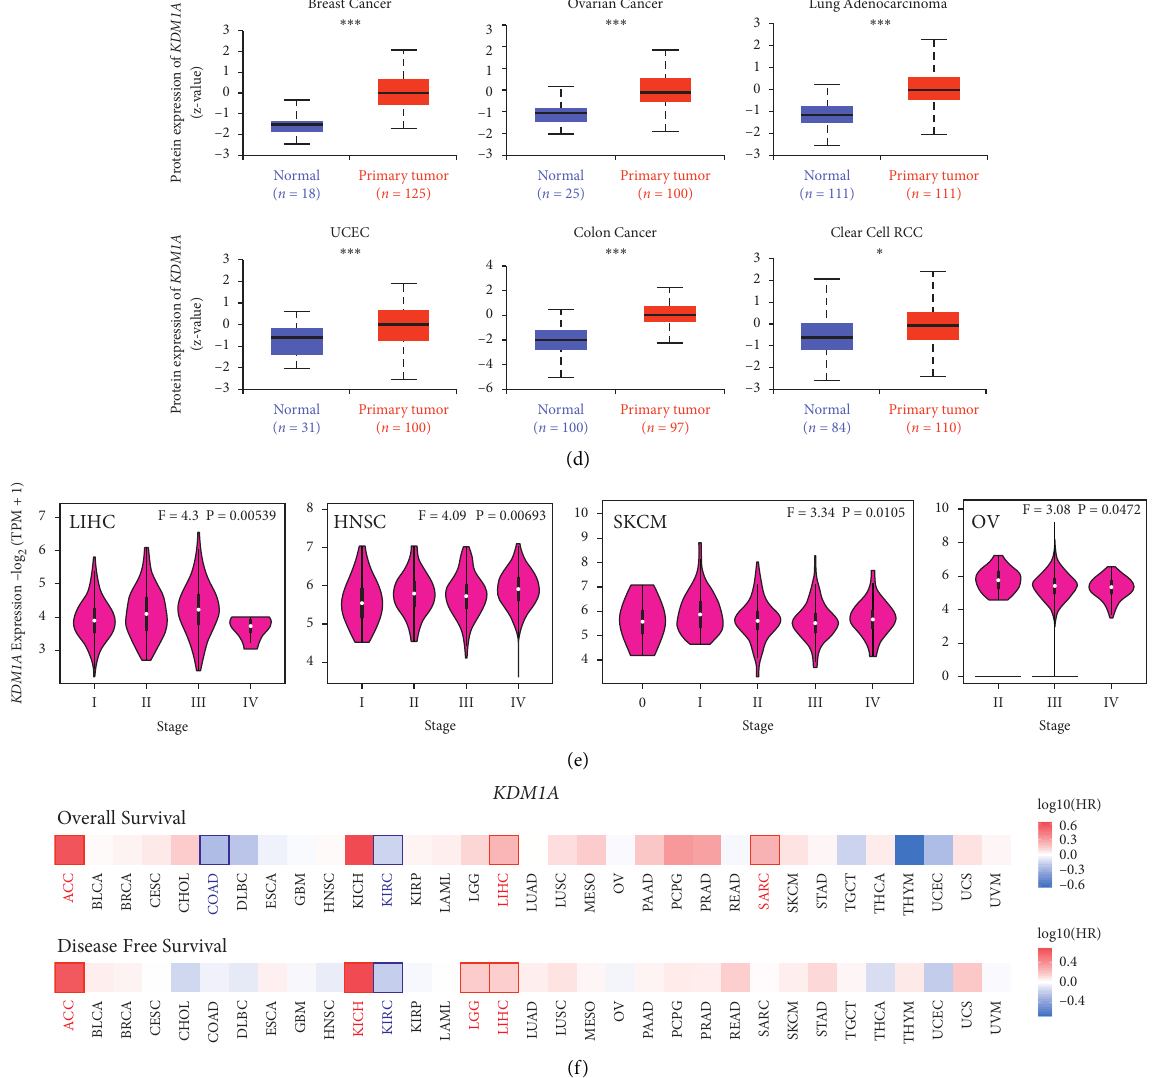
Figure 1: Analysis of the expressional level of KDM1A gene and survival prognosis of cancers. (a) TIMER2.0 was used to analyze the expressional level of the KDM1A in different cancers. (b) The box plot data were supplied for the type of DLBC, LAML, and THYM in the TCGA project, and the corresponding normal tissues of the GTEx database were included as controls. (c) Expressional levels of KDM1A in different types of tumors according to the Oncomine database. The plot indicated the numbers of datasets with statistically significant ( p < 0.05) mRNA overexpression (red) or downexpression (blue) of KDM1A (different types of cancer vs. corresponding normal tissue). (d) The protein expressional levels of KDM1A were analyzed according to the CPTAC dataset. (e) The main pathological stages of KDM1A expression levels in LIHC, HNSC, SKCM, and OV based on the TCGA data. (f) Survival prognosis of cancers including overall survival and disease-free survival. ∗ p < 0.05; ∗∗ p < 0.01; ∗∗∗ p <